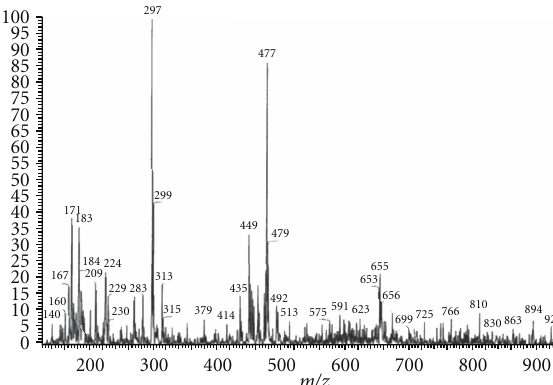
Scheme 1: Proposed structure of the Nickel complexes.